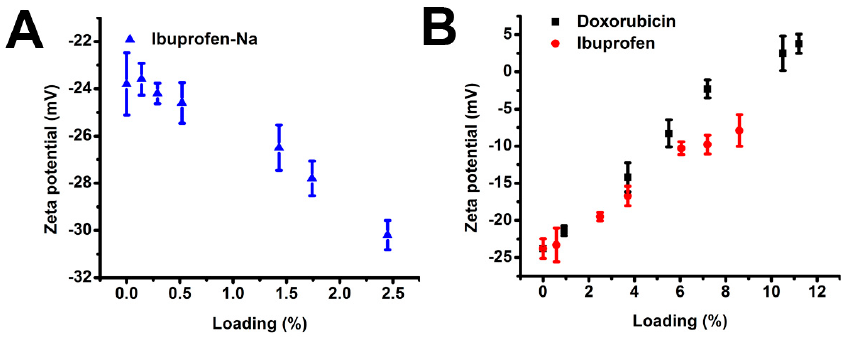
Figure 3. Zeta potential of ( A ) ibuprofen-Na and ( B ) doxorubicin and ibuprofen loaded on Ap F nanoparticles.